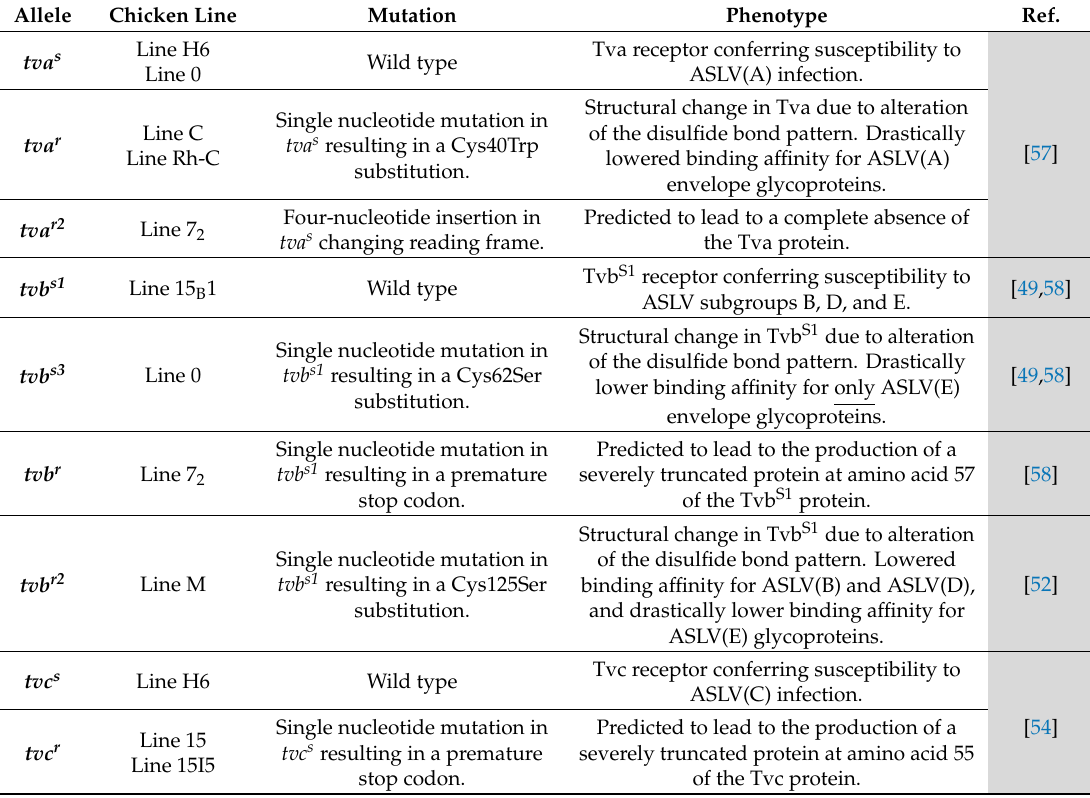
Table 1. The characterized chicken ASLV receptor alleles including the genetic defects and phenotypes of the known ASLV receptor resistance